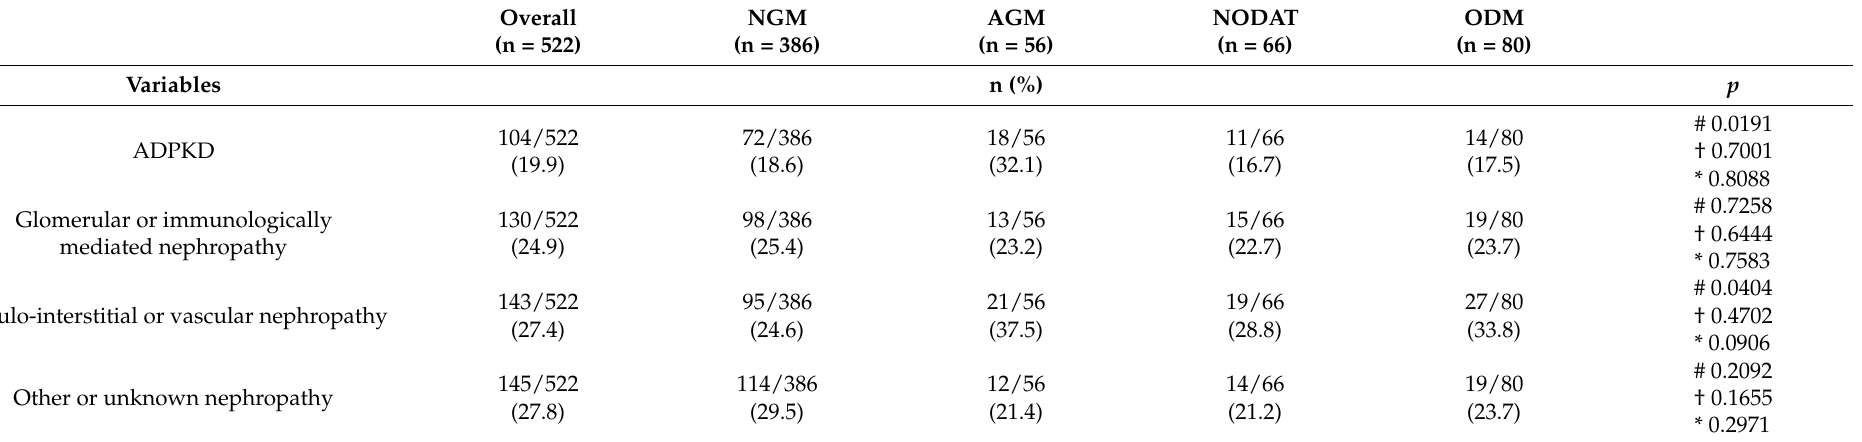
Table 2. Primary renal diseases of kidney transplant recipients with normal glucose metabolism (NGM), abnormal glucose metabolism (AGM), or new-onset diabetes mellitus after transplantation (NODAT).